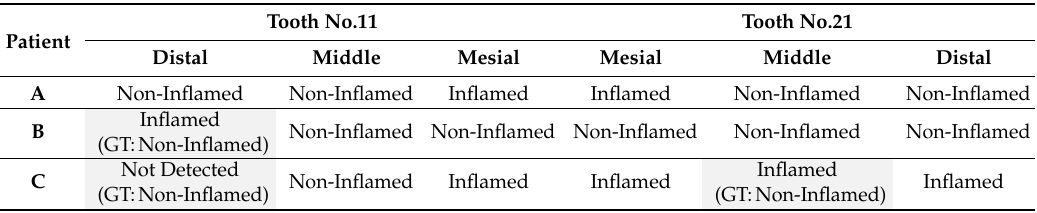
Figure 5. Sample images correctly annotated. ( A ): all six regions are correctly detected. ( B ): distal in tooth No. 11 incorrectly detected as inflamed. ( C ): distal in tooth No. 11 not detected; middle in tooth No. 21 incorrectly detected as inflamed. Table 2. The results of the inflammation detection model for 3 patients. The detection results match the clinical findings except for the highlighted regions (GT = ground truth).